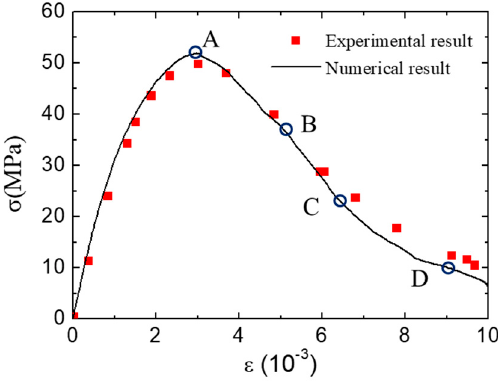
Figure 13. Stress-strain curve of concrete under uniaxial compression in high-friction (HF) condition.